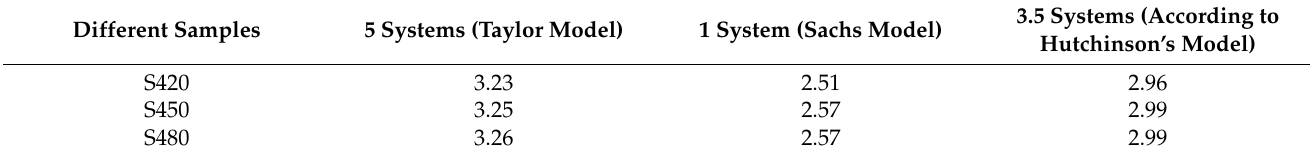
Table 3. Average M values for macroscopic loading in the rolling direction of three different